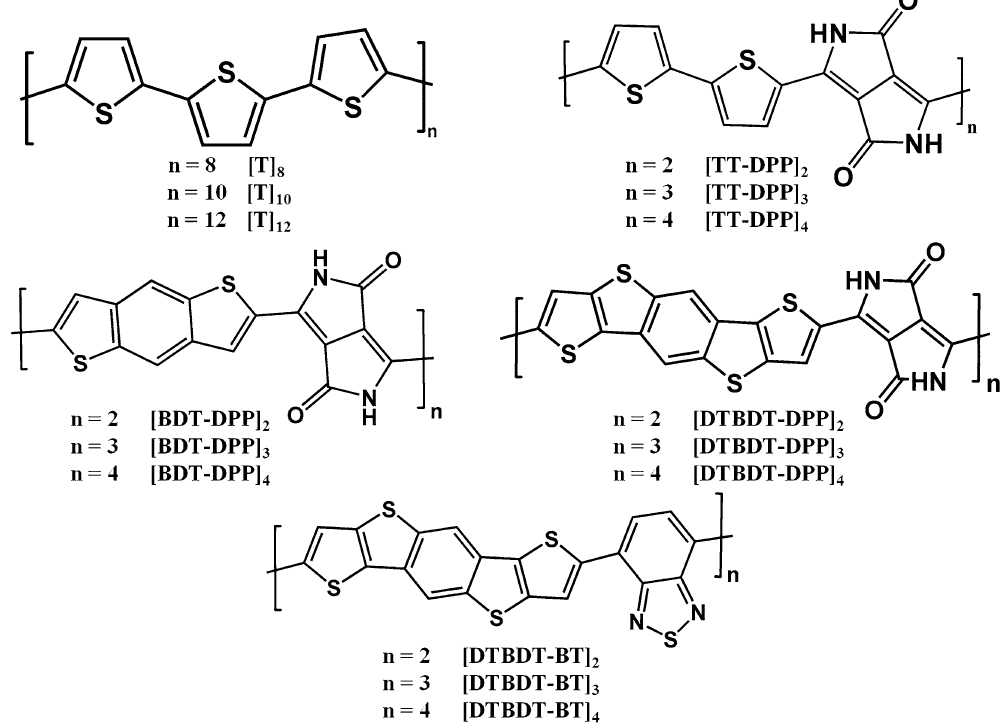
Figure 1. Chemical structures of donor–acceptor based conjugated systems considered in this